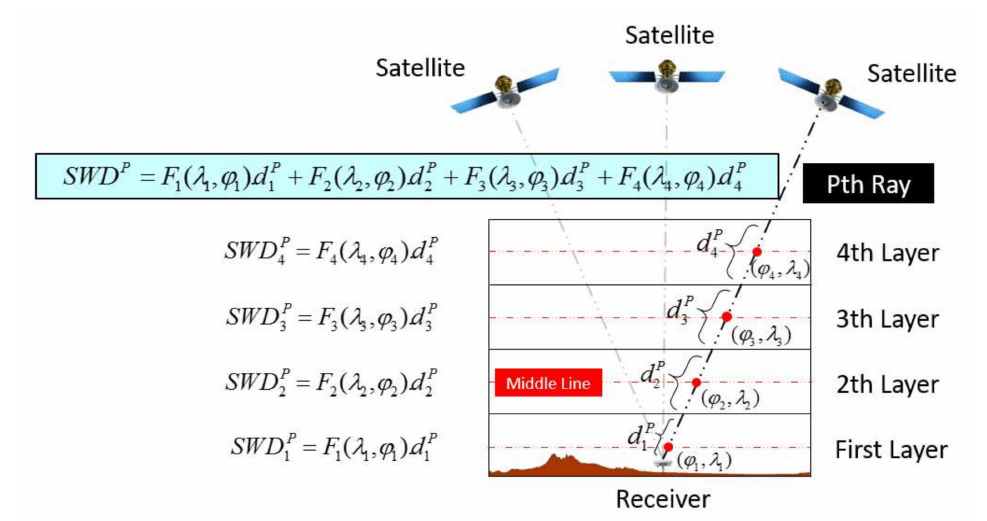
Figure 1. Sample design of four-layer function-based troposphere tomography